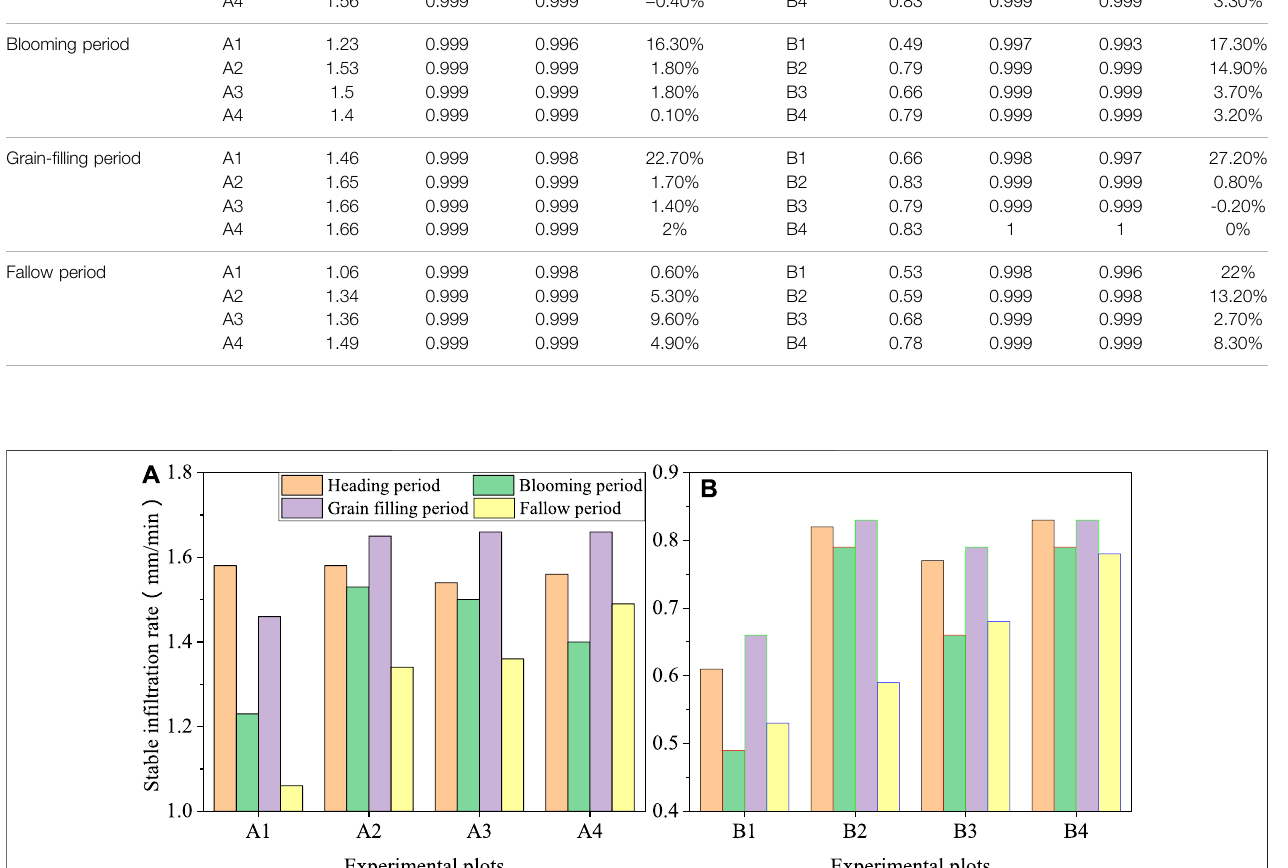
Frontiers in Earth Science |